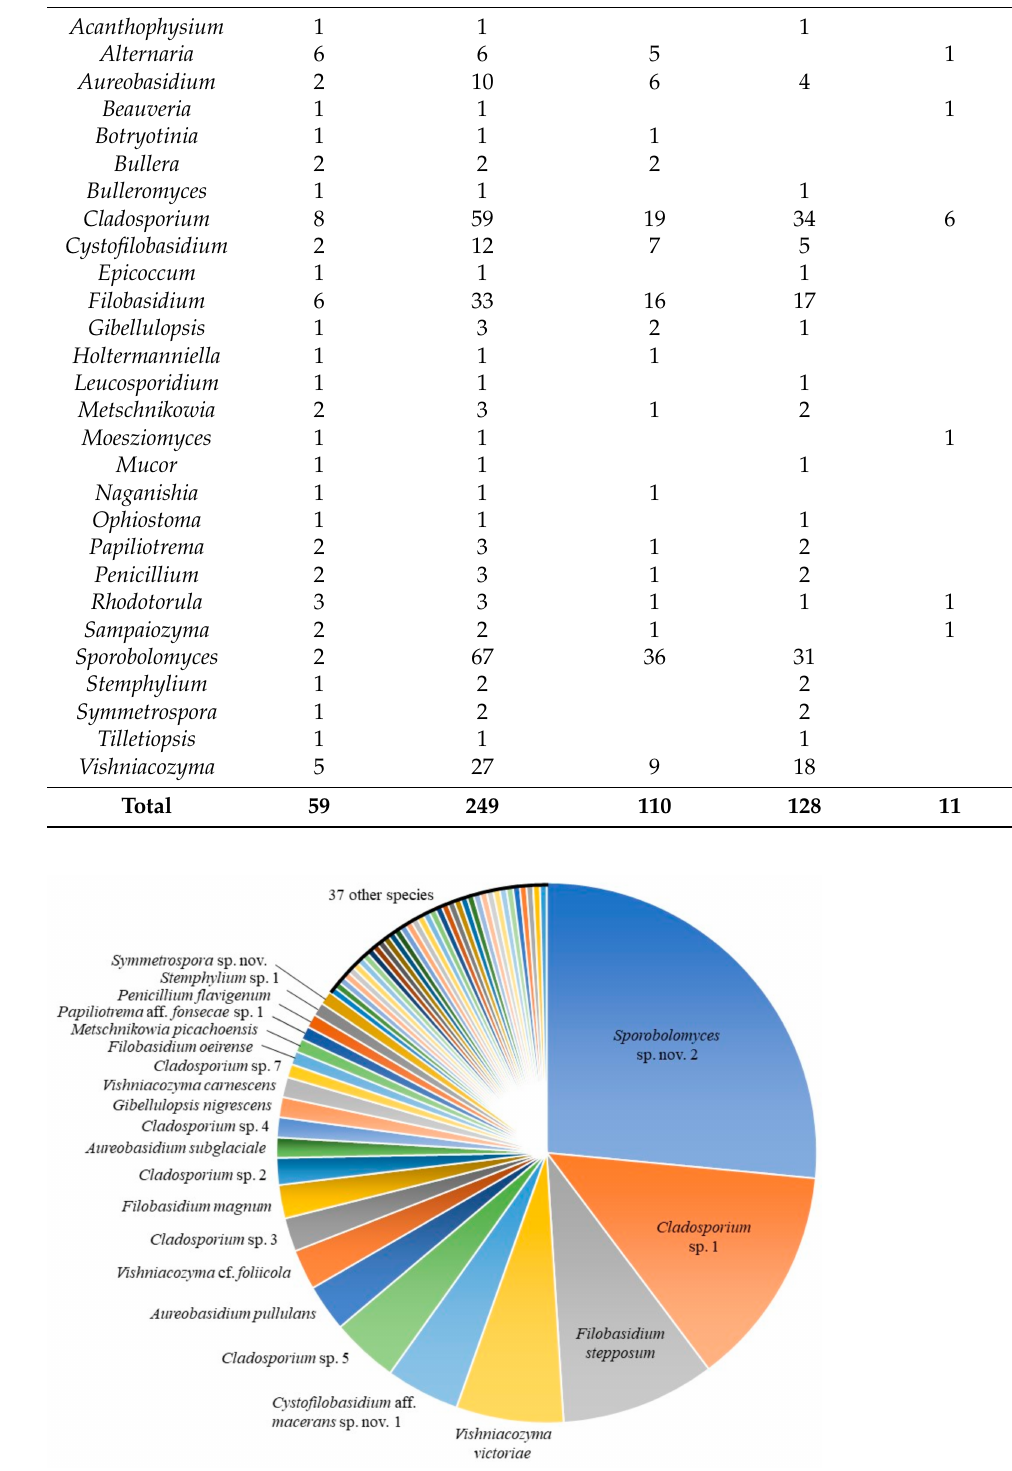
Figure 1. Overview of the 59 species obtained from all lettuce samples analyzed in this study, by number of isolates. Only species with 2 or more isolates are